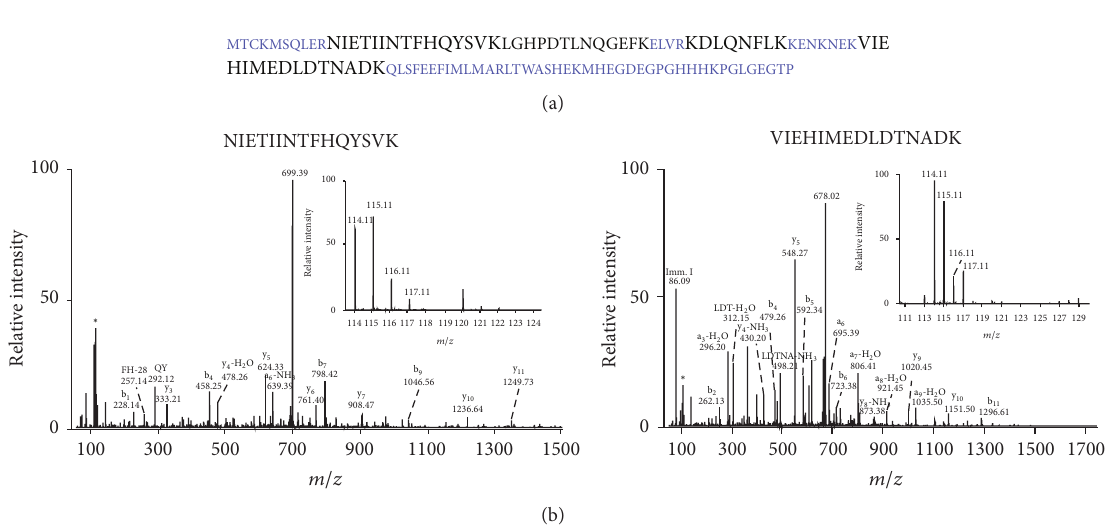
Figure 1: Protein sequence of S100 calcium binding protein A9 and the representative MS/MS spectra of peptides from S100 calcium binding protein A9. (a) Protein sequence of S100A9 and the peptides (in black) mapping to S100A9 protein identified in our ESCC tissue proteomics study. (b) MS/MS spectra of peptides mapping to S100A9 protein identified in ESCC tissue proteomics study. The inset shows reporter tags reflecting relatively higher expression in normal esophageal epithelia (114 and 115 reporter tags) as compared to ESCC tissue (116 and 117 reporter